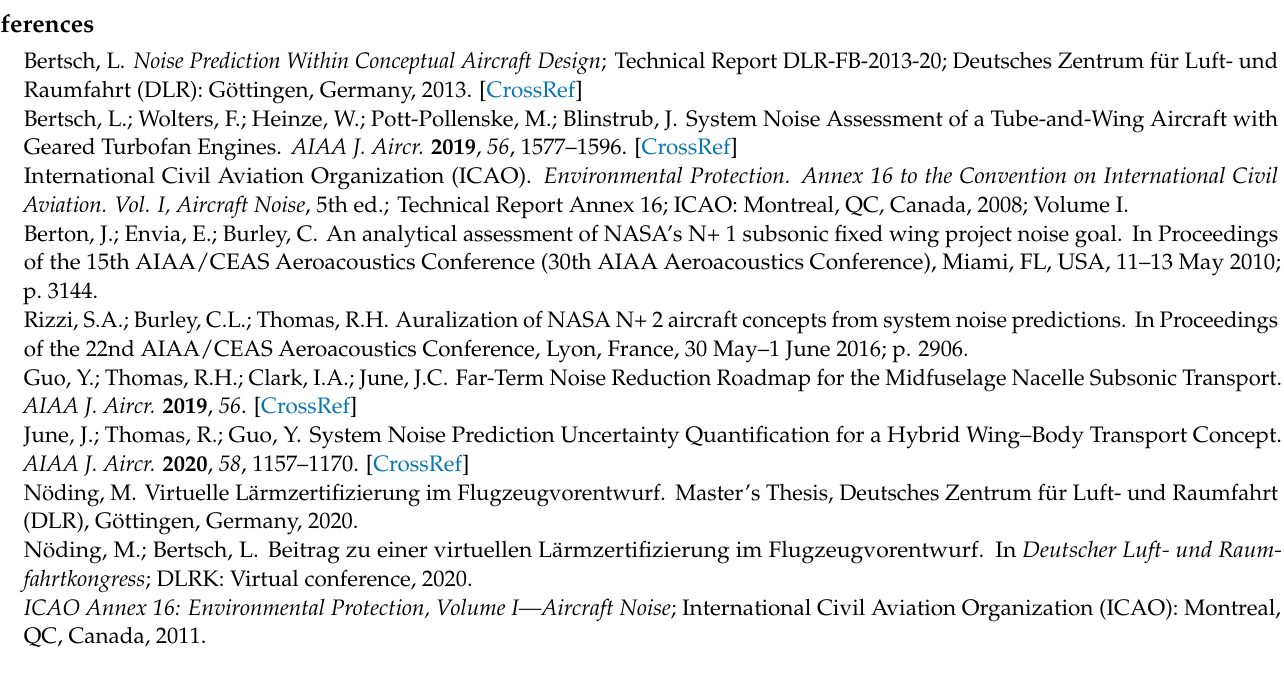
Figure A1. Visualization of Effective Perceived Noise Level Calculation from measured Sound pressure